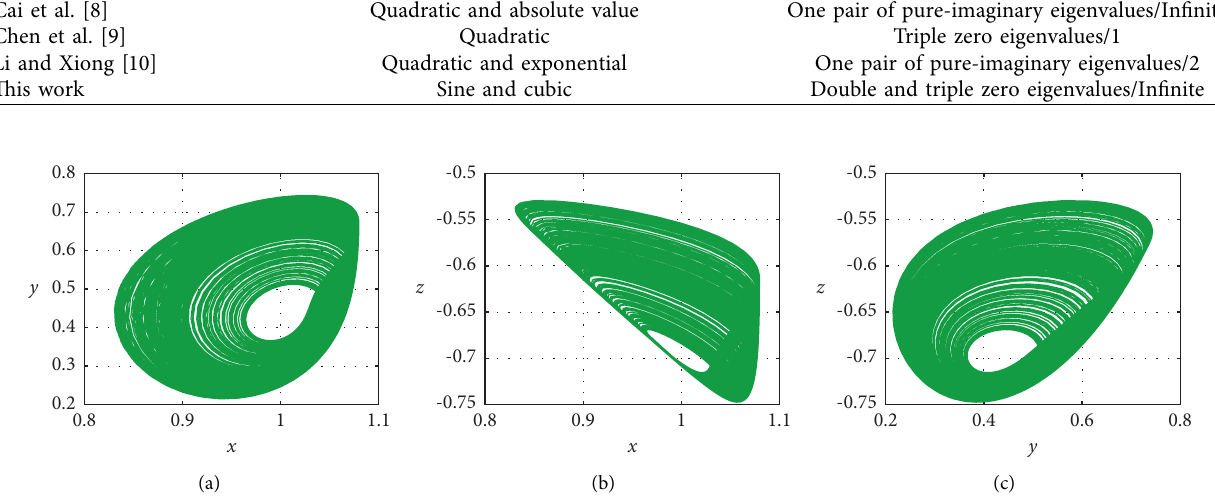
Figure 1: Phase portraits of the system with ( p (a) x - y plane, (b) x - z plane, and (c) y - z plane.